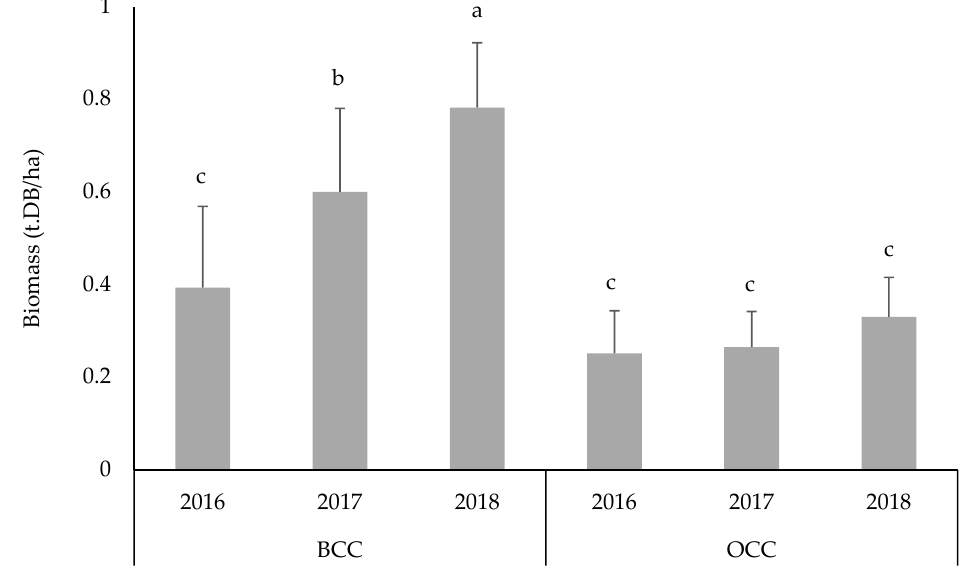
Figure 5. Inter-annual variation of biomass (BCC) below the Casuarina canopy (OCC) and outside the Casuarina canopy. Lower-case letters (a–c) indicate significant di ff erences between the years 2016, 2017, and 2018 for each condition.